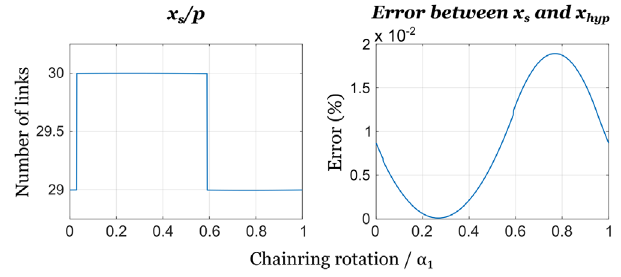
Fig. 16. Evolution of x s / p .